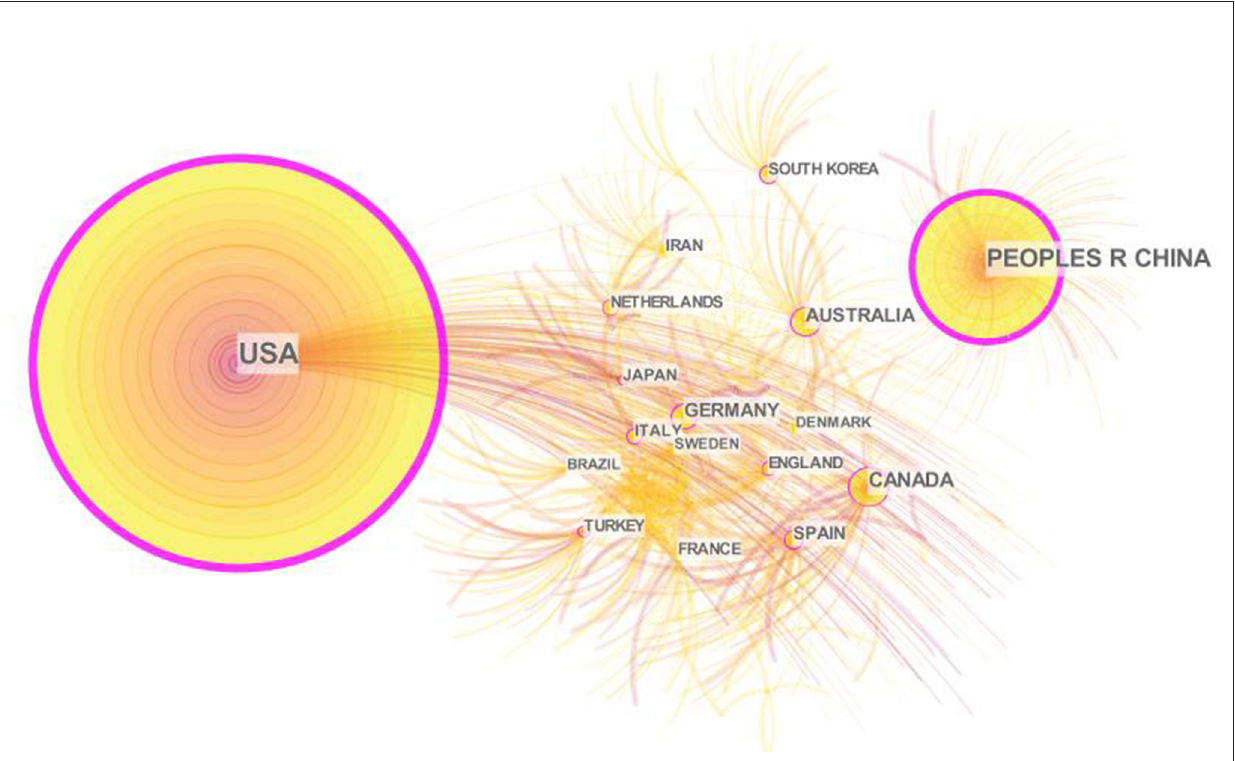
FIGURE2 Collaboration network of countries/regions on cancer and sleep research from 2002 to 2022.